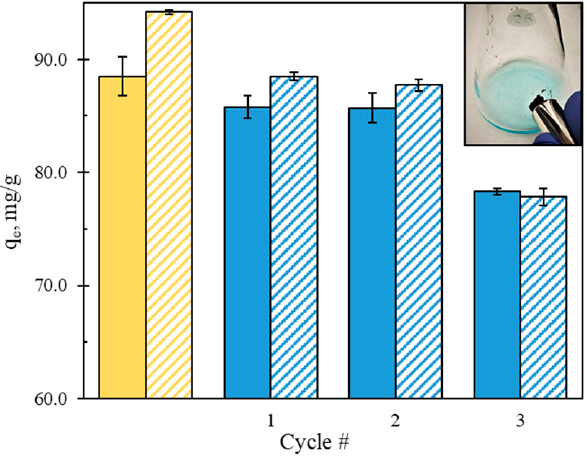
Figure 8. Recyclability of TPNi (solid pattern—in the dark, stripes—under purple light) and the separation of the carbon sample with a magnet. Shown in yellow are the original runs at the test conditions of pH 6, 60 mg/L MB, 600 mg/L TPNi, and 1:1:0.5 T:P:Ni ratio. The sample appeared to be highly magnetic and was easily separated with the